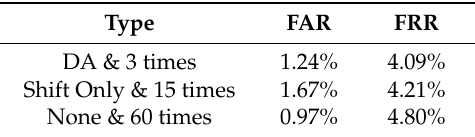
Table 2. FAR and FRR score of using or not using data augmentation